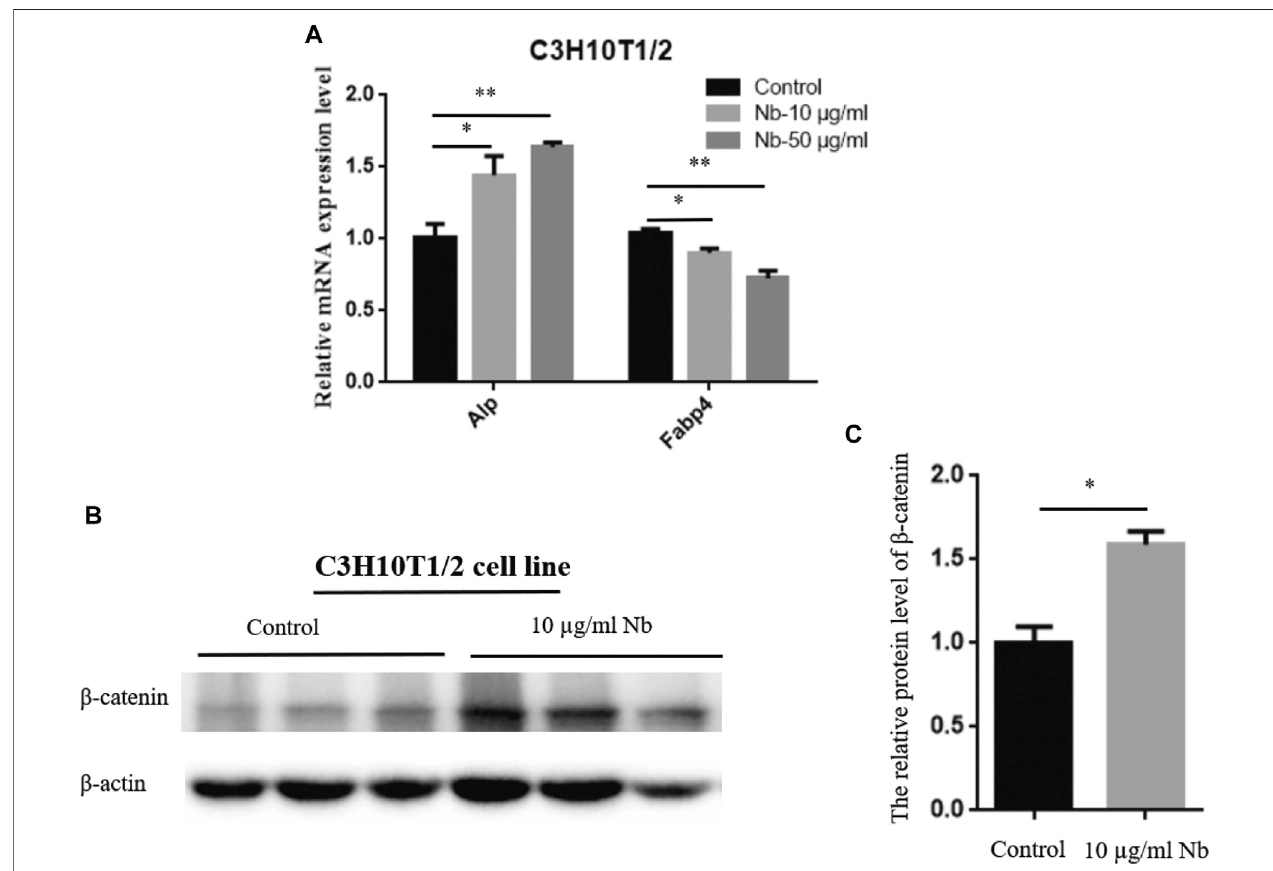
FIGURE 3 | SSTZF-NB upregulates ALP mRNA, FABP4 mRNA expression (A) , and β -catenin protein level (B) in C3H10T1/2 cells. (C) The relative protein level of β -catenin.